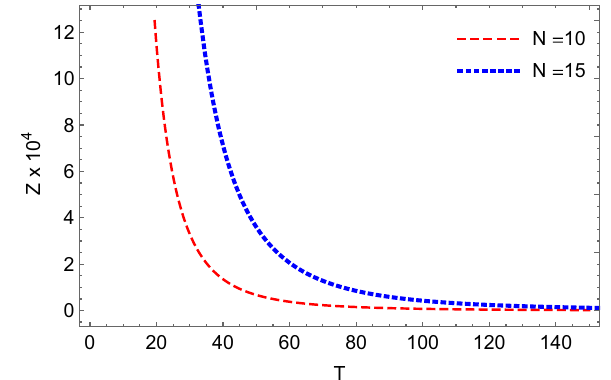
Fig. 8 Partition function in terms of temperature with G = m = k = 1, and λ = 1 / 6